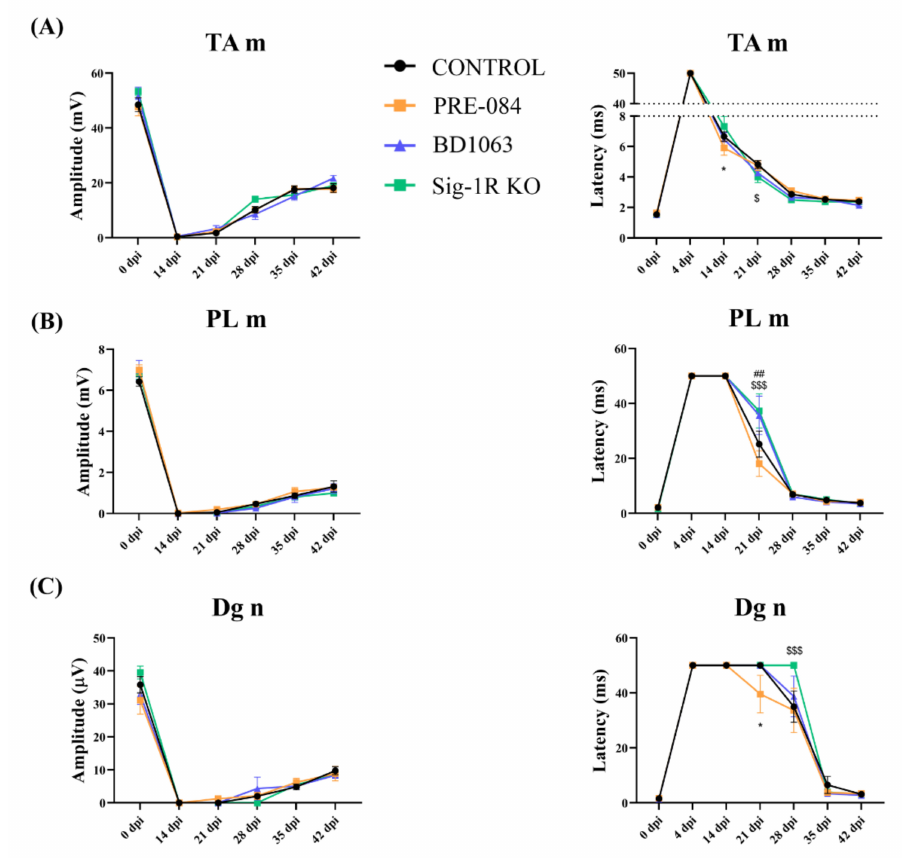
Figure 3. Electrophysiological results. Plots of CMAP amplitude and latency recorded from TA ( A ); and PL ( B ) muscles; and of CNAP amplitude and latency of the digital nerve ( C ) during the follow-up in the studies of Sig-1R ligands and Sig-1R KO mice. Values are mean ± SEM.